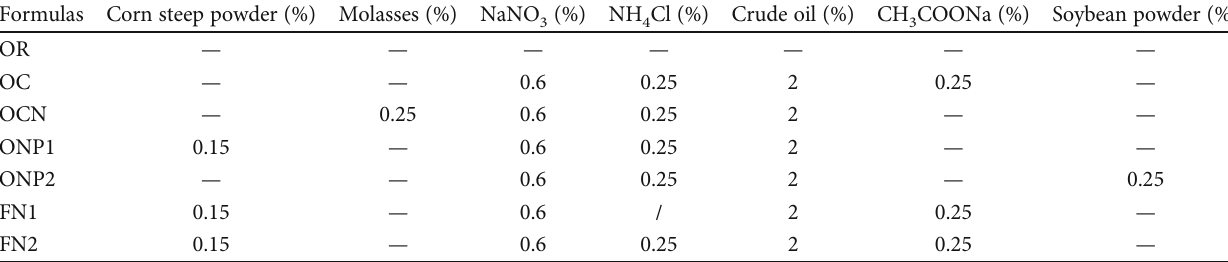
Table 1: Stimulation formulas.